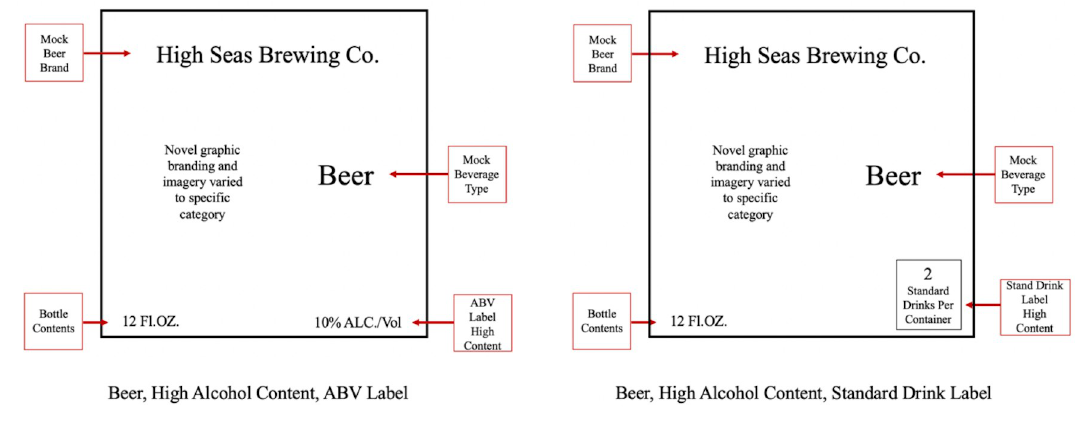
Fig 1. Example stimulus